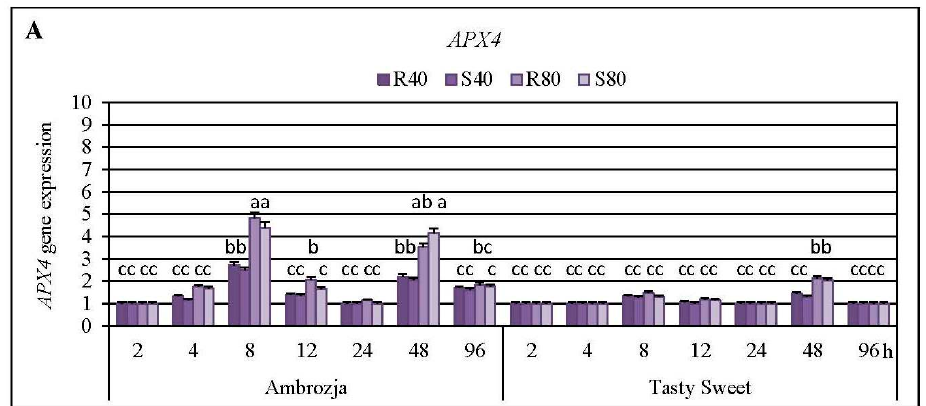
Figure 3. Effect of the cereal aphid’s herbivory on relative expression of APX1 ( A ) and APX2 ( B ) genes in the seedlings of Ambrozja and Tasty Sweet maize varieties (first phase of the experiments). R40, R80—maize plants of a certain genotype infested with 40 or 80 R. padi females per seedling, accordingly; S40, S80—maize plants of a certain genotype infested with 40 or 80 S. avenae females per seedling, respectively. All data are presented as the mean ( ˘ SD) of three independent biotests, and significant differences in abundance of the APX transcripts are denoted by different letters ( p < 0.05; post-hoc Tukey’s test).